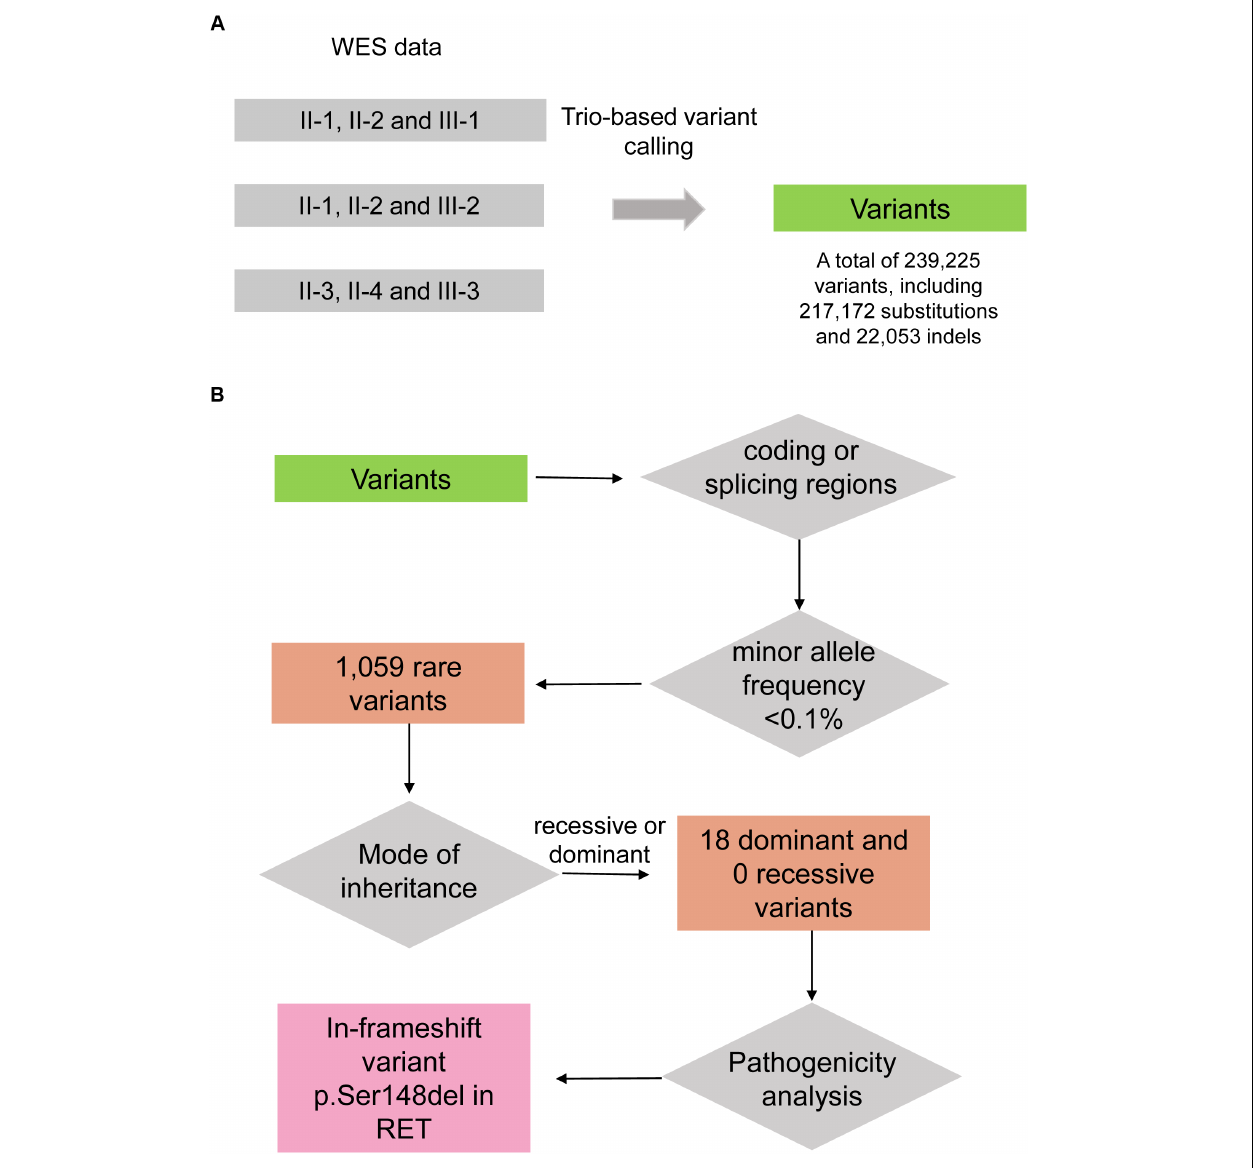
FIGURE 2 | The workflow of discovering the disease-causing variant for the HSCR family. (A) Variants are called by VarScan with the trio-based calling mode. (B) The disease-causing variant is identified by filtering steps including falling within coding/splicing regions, the minor allele frequency (MAF) in healthy population, mode of inheritance, and pathogenicity